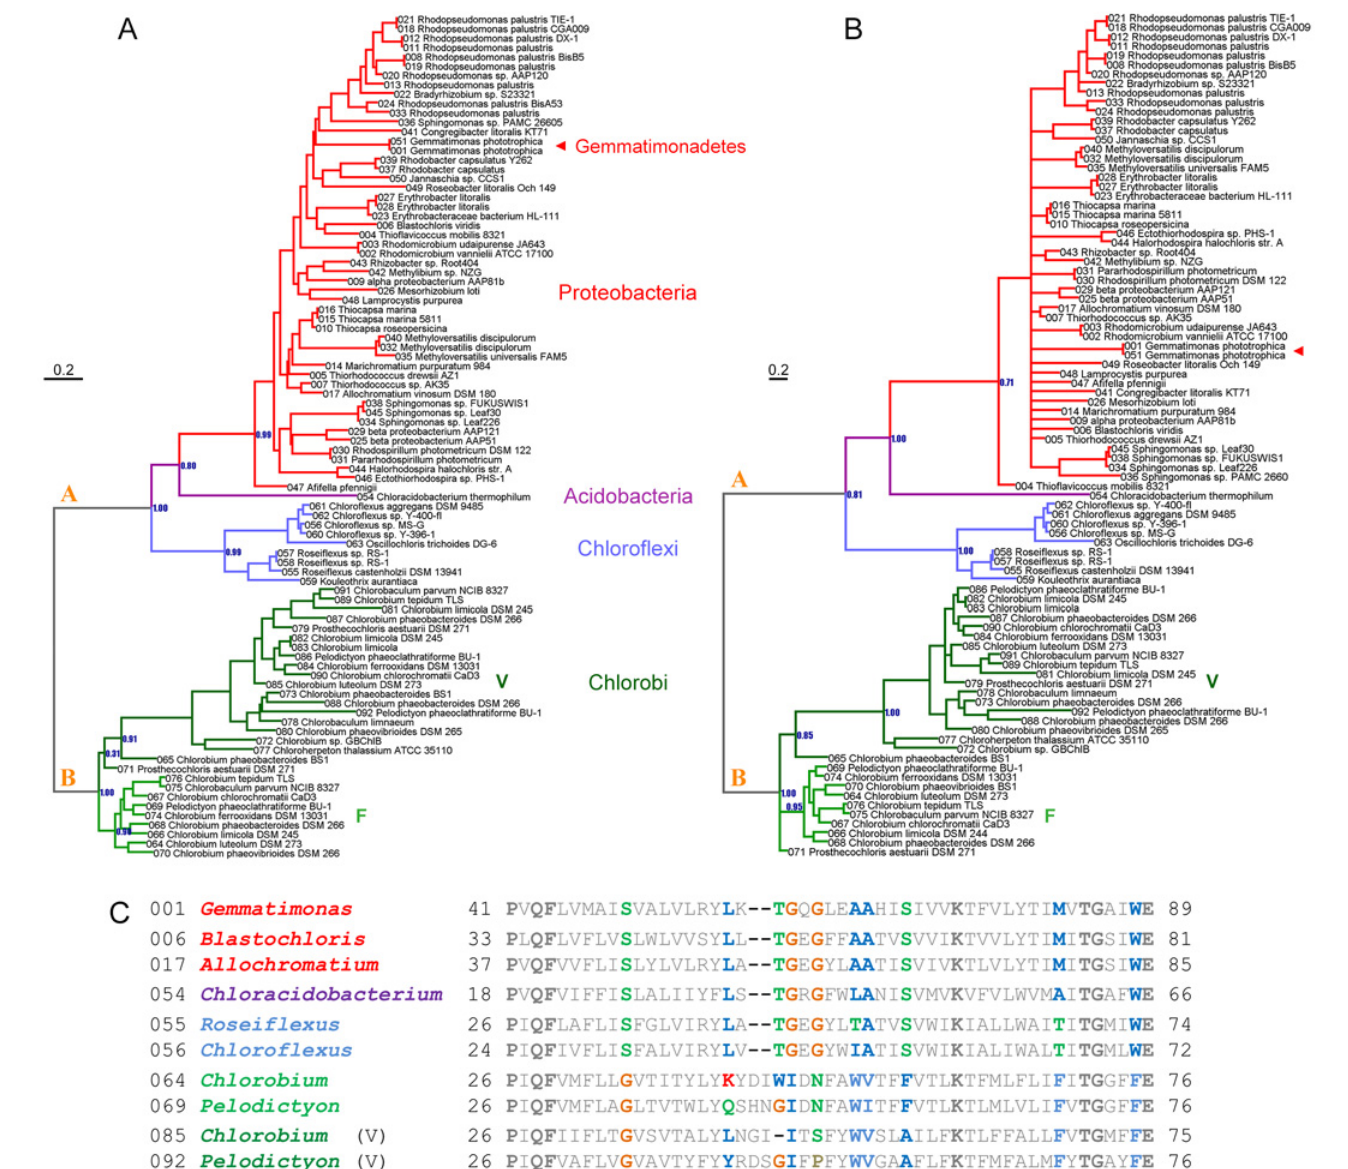
Fig 1. Phylogenetic trees of the BchF protein. A shows a Maximum Likelihood tree and B shows a tree calculated using Bayesian Inference. The scale bar represents the average number of substitutions per site. C shows a sequence alignment of a BchF fragment of selected strains representatives of all phyla. In color bold letters I highlighted conserved positions which differentiate the Chlorobi-type from those in the remaining phyla as described in the text. The V in parenthesis denotes the paralogue sequences to BchF usually found in the genomes of phototrophic Chlorobi. The phylogenetic trees and complete sequence alignments are provided in S1